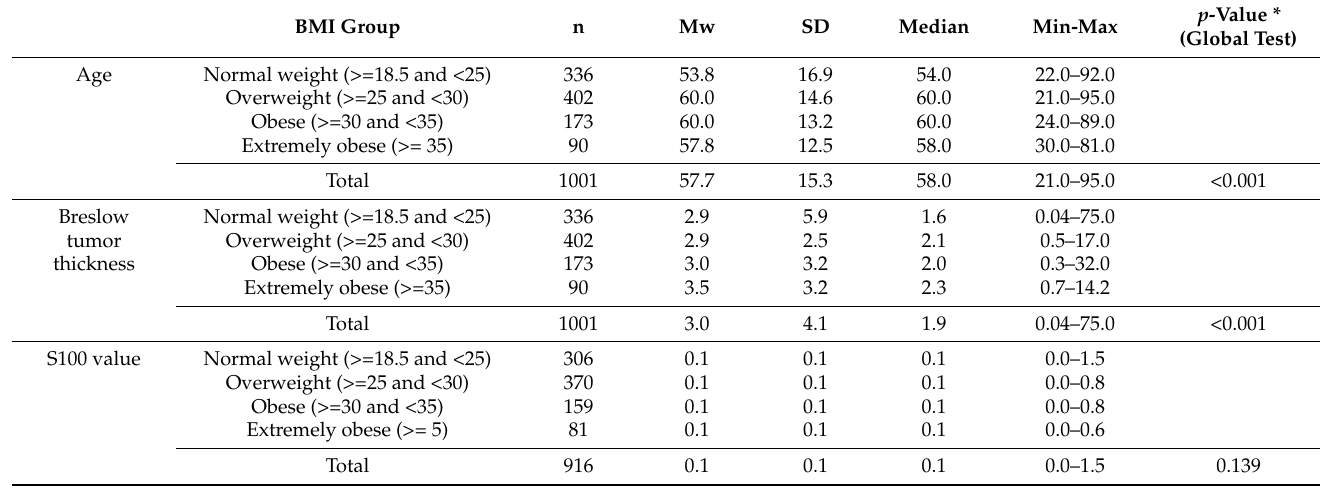
Table 1. Description and comparison of BMI groups—metric characteristics.